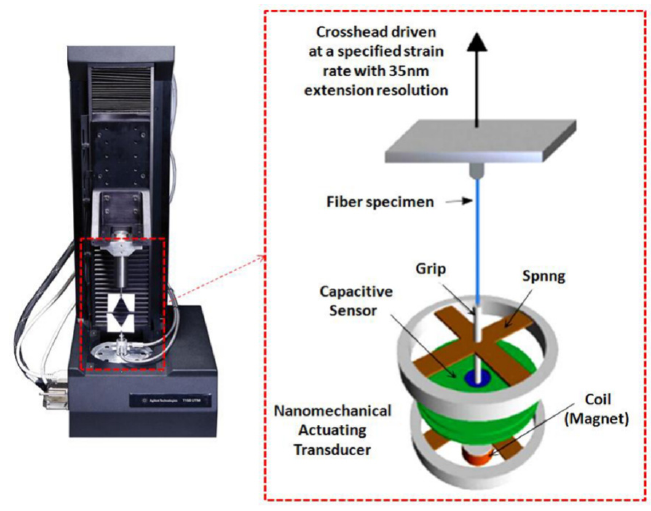
Figure 5. Tensile testing system for single nanofibers.